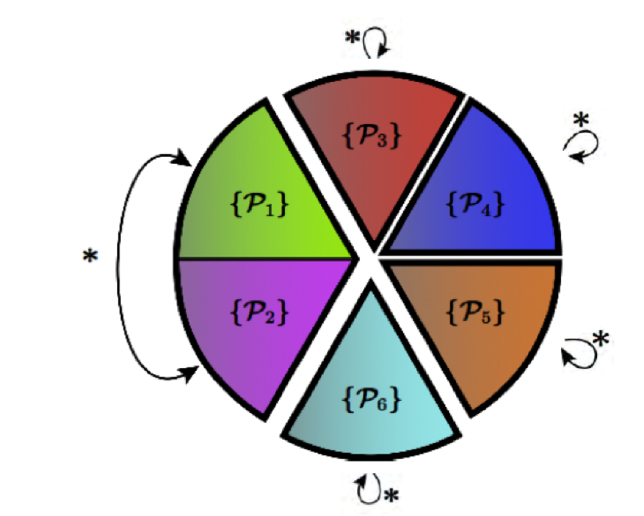
Figure 5 . “Hodge Duality” mapping of BC 4